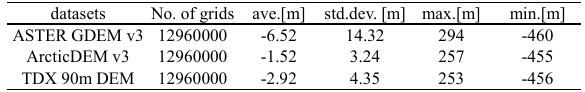
Table 2. Statistics of height differences in